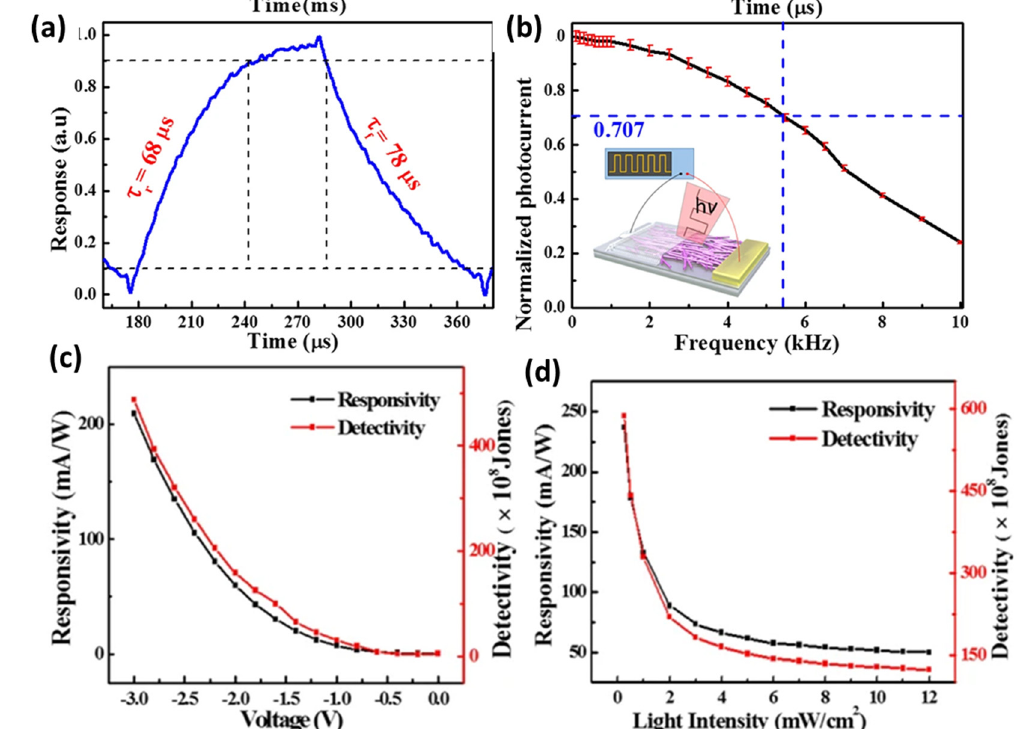
Figure 4. Photoresponse of the PD. ( a ) Single normalized cycle measured at 5 kHz for evaluating both rise ( τ r ) and fall time ( τ f ). ( b ) Normalized photocurrent versus switching frequency. ( c ) Responsivity and detectivity of the PD as a function of bias voltage. ( d ) Responsivity and detectivity of the PD as a function of light intensity. (Adapted from [80]).